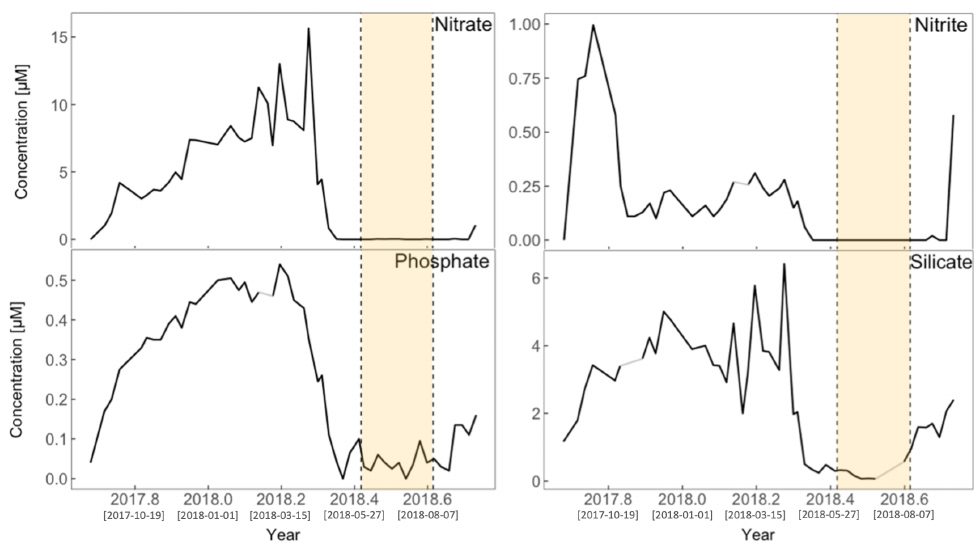
Figure 8. Surface nutrient concentrations at L4 over the study period. Lighter shades (grey) represent interpolation for instances where data were unavailable. The yellow shaded area represents the summer period June to August. Square bracketed dates on the x-axis ticks represent Year-Month-Day.